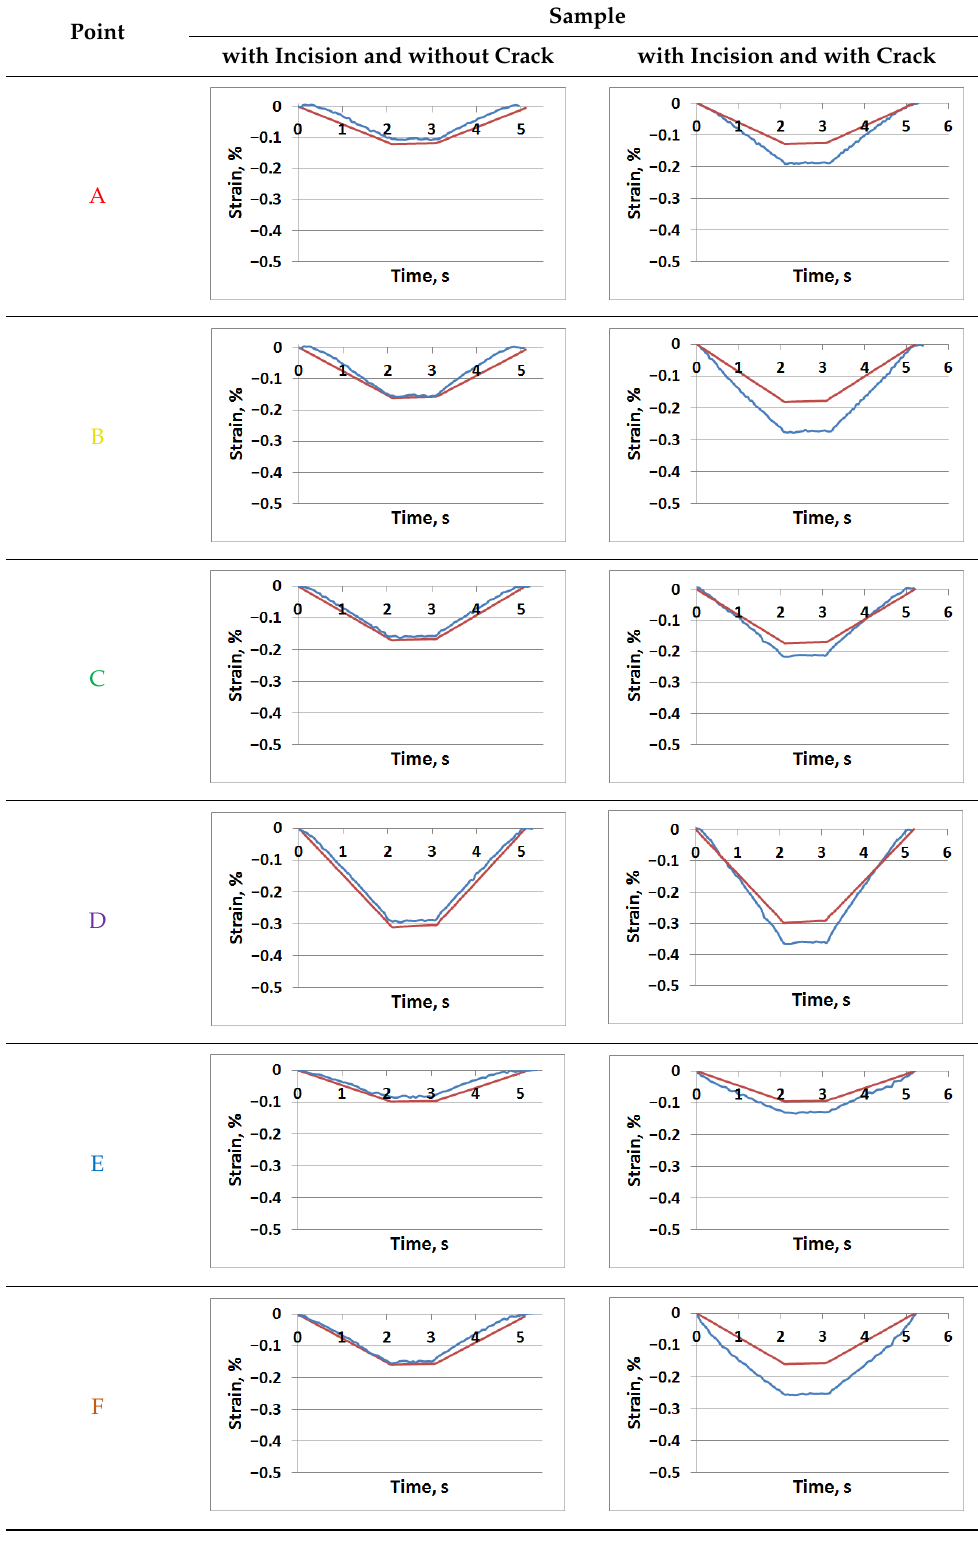
Table 1. Temporal dependencies of strain in Points A–F (Figure 6) obtained by DIC (blue) and FEM (red).